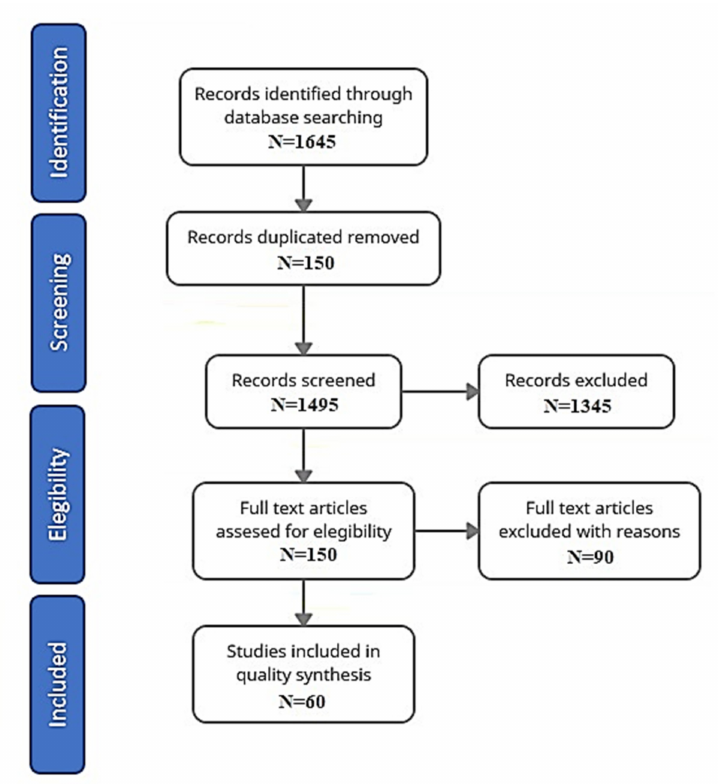
Figure 2. Literature review based on PRISMA